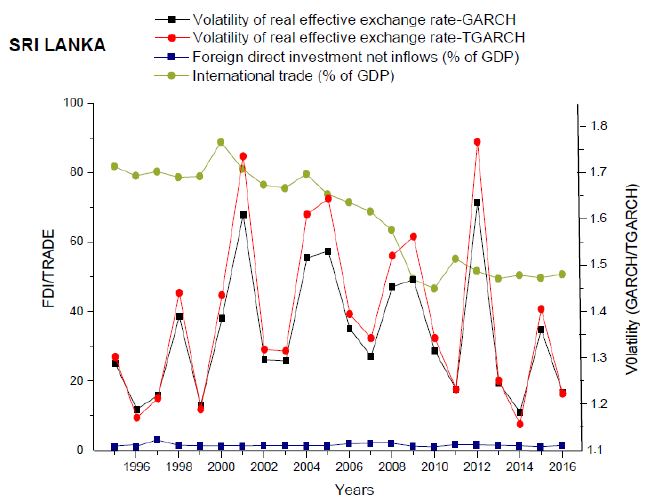
Figure 6. Exchange Rate Volatility vs. FDI/Trade (Pakistan).